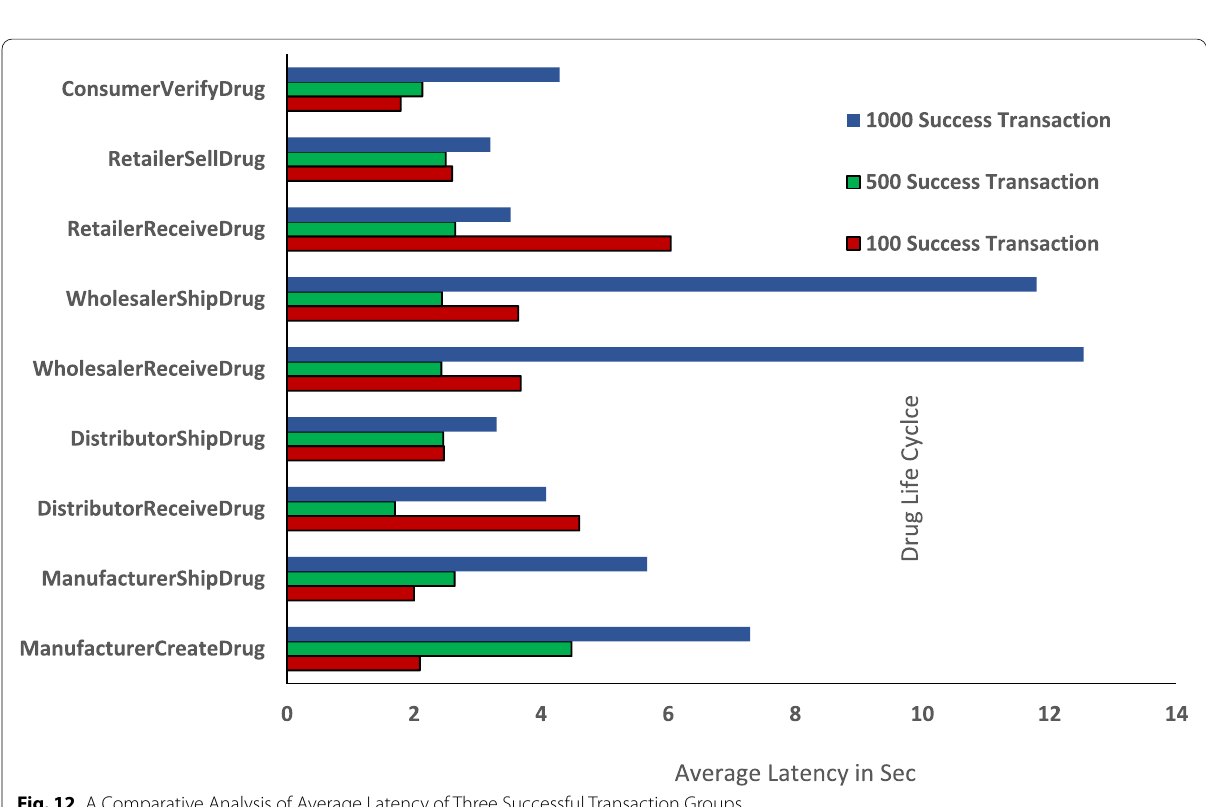
Fig. 12 A Comparative Analysis of Average Latency of Three Successful Transaction Groups